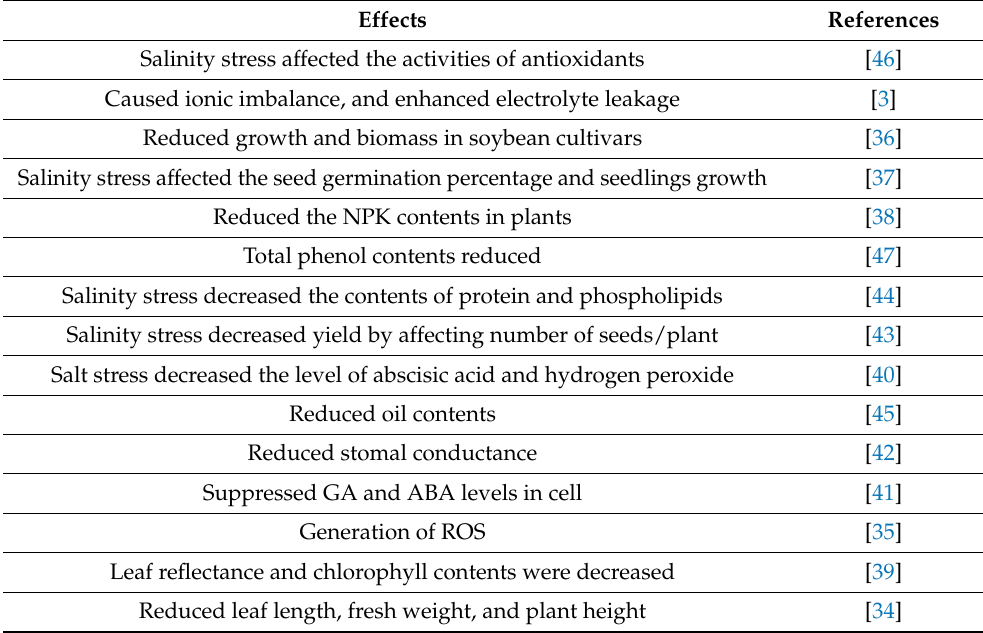
Table 1. Salinity stress affects soybean’s morphological, physiological, and biochemical traits.